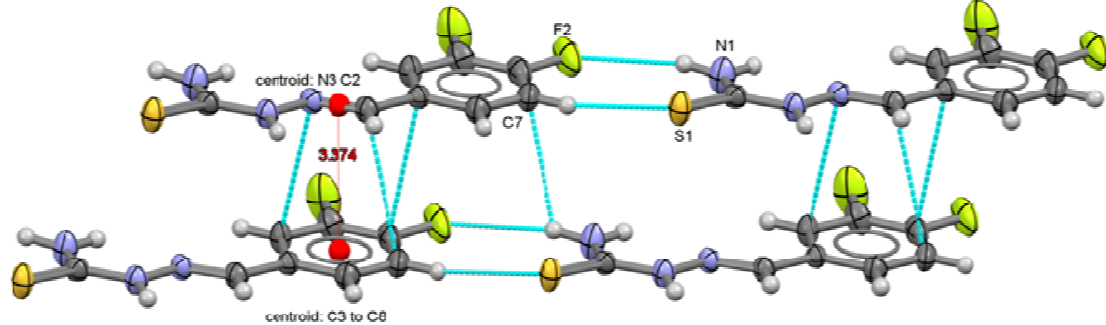
Figure 10. Packing arrangement of 3,4-C interactions between thiophenolate rings.